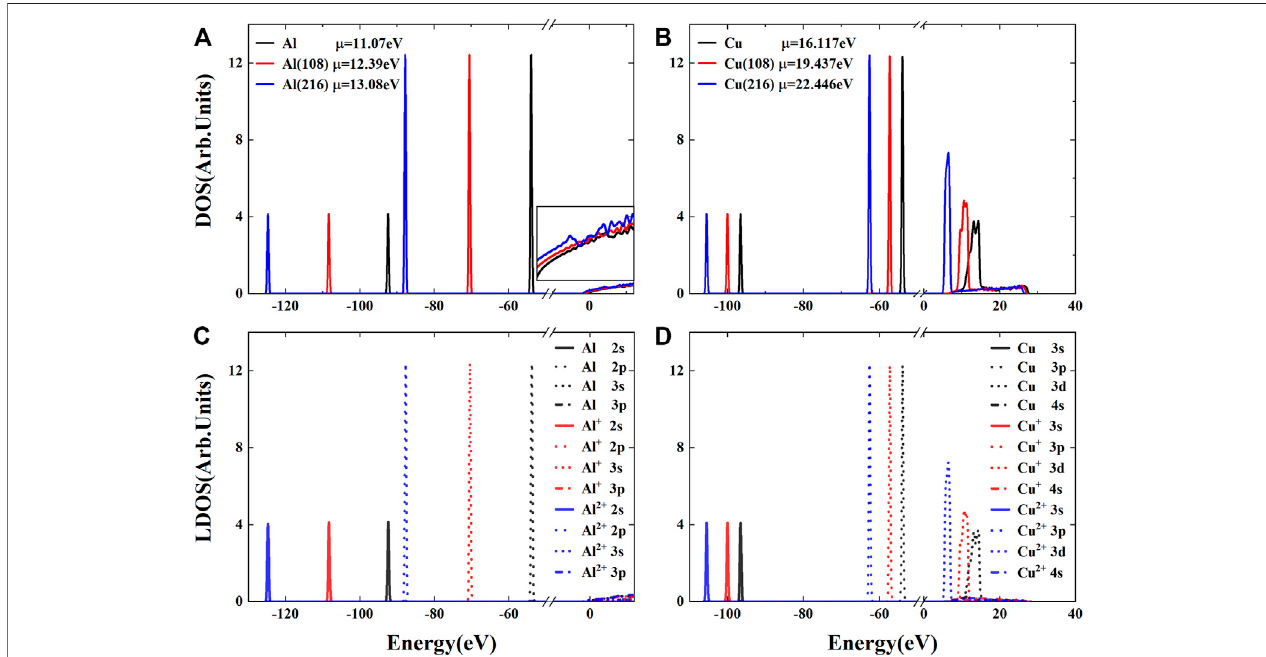
FIGURE 1 | Density of states of Al and Cu and the local density of states of Al and Cu with perfect lattice structure at room temperature. The black solid curves correspond to the DOS or LDOS without a hole in the system. (A) DOS of atoms of Al with one (red color) hole and two (blue color) holes in the 2s orbital. Their corresponding chemical potentials are labeled in the legends as well. (B) DOS of atoms of Cu with a (red color) hole and two (blue color) holes in the 3s orbital. Their corresponding chemical potentials are labeled in the legends as well. (C) LDOS for Al. (D) LDOS for Cu.